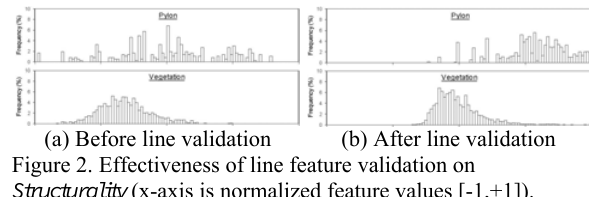
Figure 2. Effectiveness of line feature validation on Structurality (x-axis is normalized feature values [-1,+1]).